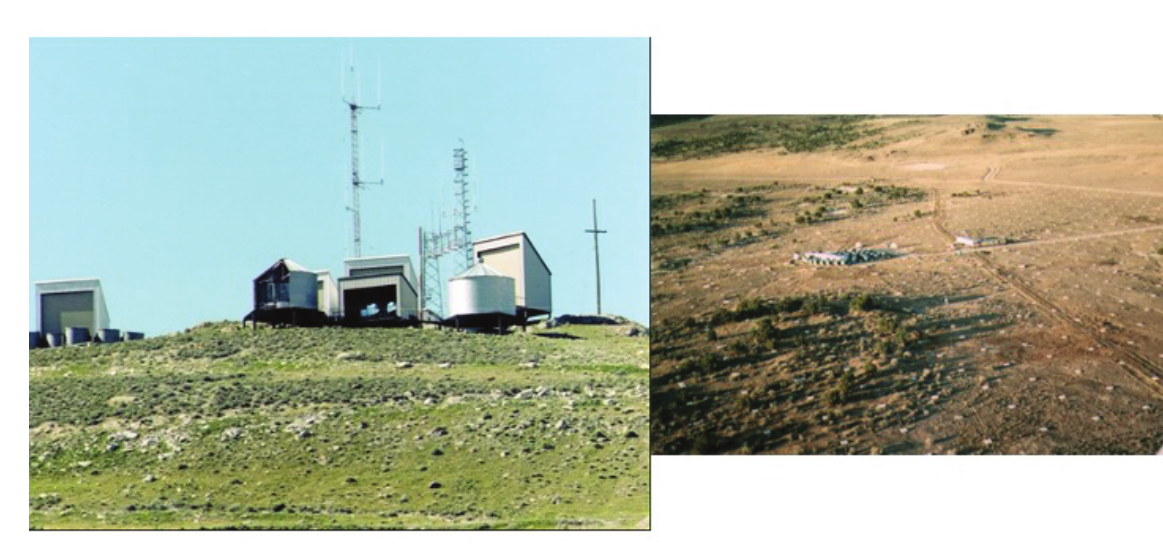
Figure 7. HiRes Prototype detector on 5 Mile Hill [L], CASA / MIA array with FE2 at the center [R]